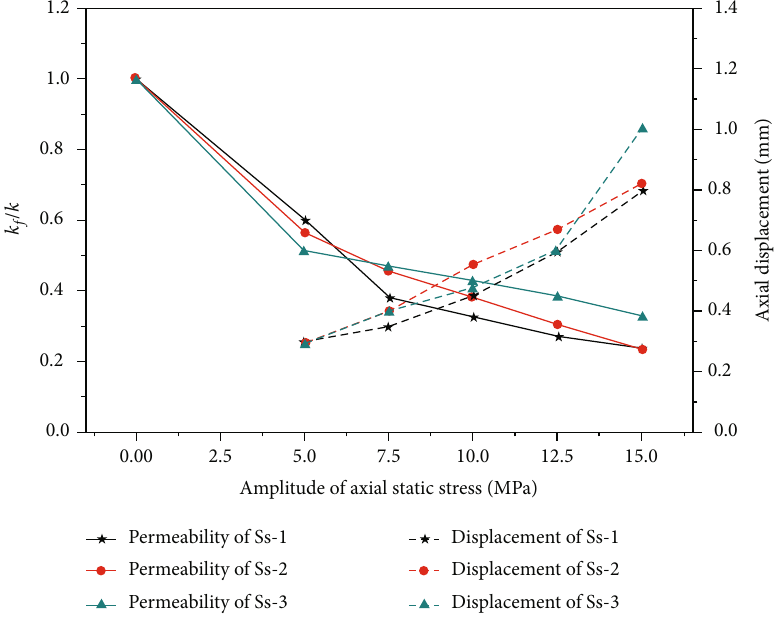
Figure 8: Permeability evolution and axial displacement of Ss-1, Ss-2, and Ss-3 under axial static